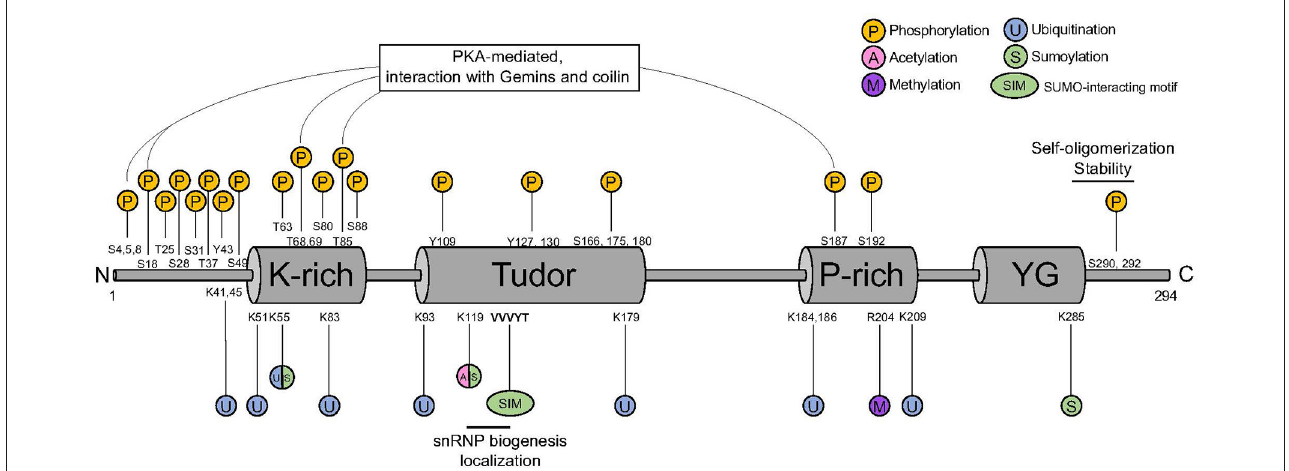
FIGURE1 SMN protein PTM sites. SMN harbors a K-rich domain, a Tudor domain, a P-rich domain, and a YG domain that are binding sites for different PTM. P, phosphorylation; U, ubiquitination; S, sumoylation; A, acetylation; M, methylation; SIM, SUMO-interacting motif; SMN, survival motor neuron; PTM, post-translational modification.